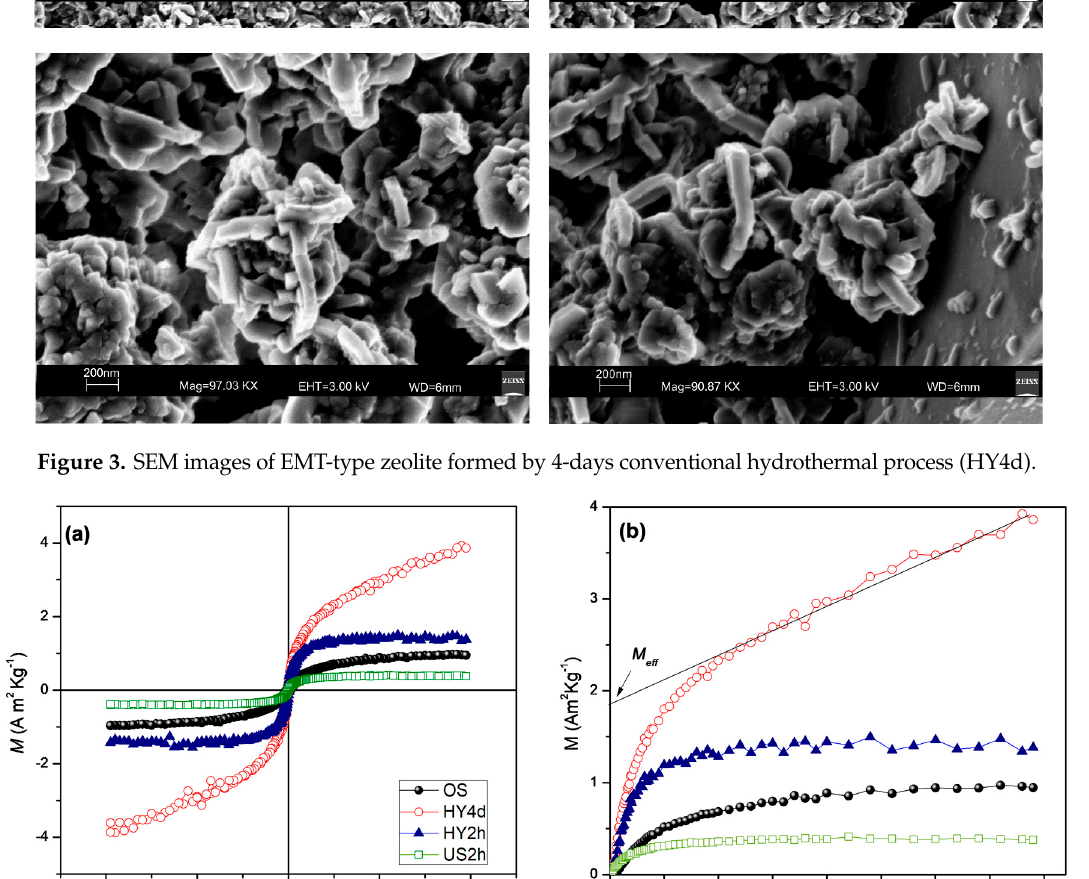
Figure 4. ( a ) Field dependence of magnetization recorded at 300 K; ( b ) Magnification M vs. H in the range 0–2 T. For all samples, extrapolation to zero of the high field linear portion of the magnetisation was used to determine the effective magnetic moment (M eff ).